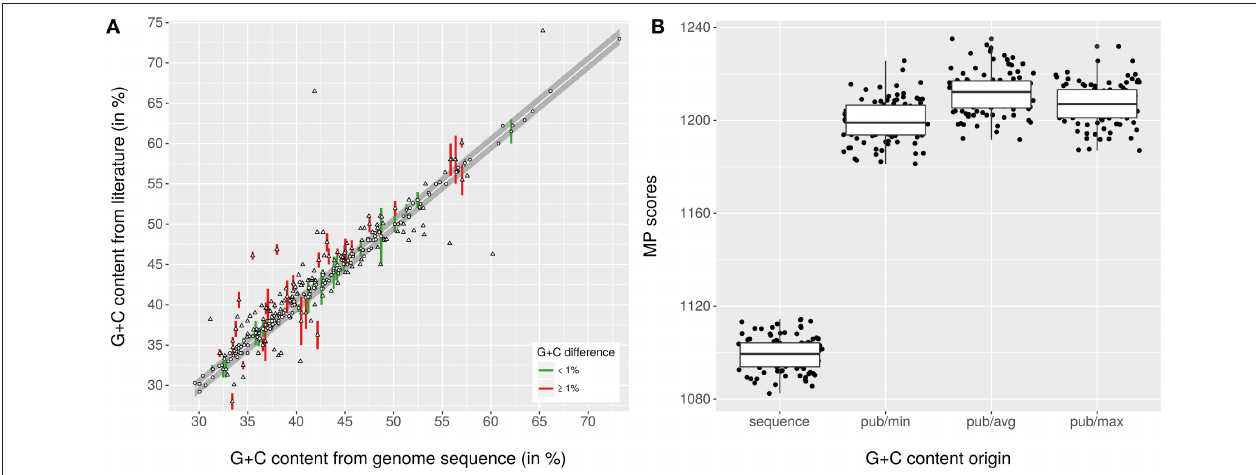
FIGURE 1 | Relationship between G + C content values from species descriptions and those calculated from the genome sequences. (A) scatter plot showing the relationship between G + C content values calculated from the genome sequences and those found in the respective last revision in the literature, mostly calculated traditionally. The gray band indicates the boundary of 1% deviation, green color (when ranges were provided) and circles indicate values within that range, red color and triangles indicate values outside that range. (B) box plots showing the MP scores calculated with TNT from the rescaled G + C content values of distinct origin (pub, published; min, avg and max refer to whether the lower, average or upper value was used when a range was given) in conjunction with the 100 pseudo-bootstrapped GBDP trees. The values calculated from the genome sequences yield a significantly lower MP score (and thus a significantly better fit to the tree) than the ones from the respective last emendation in the